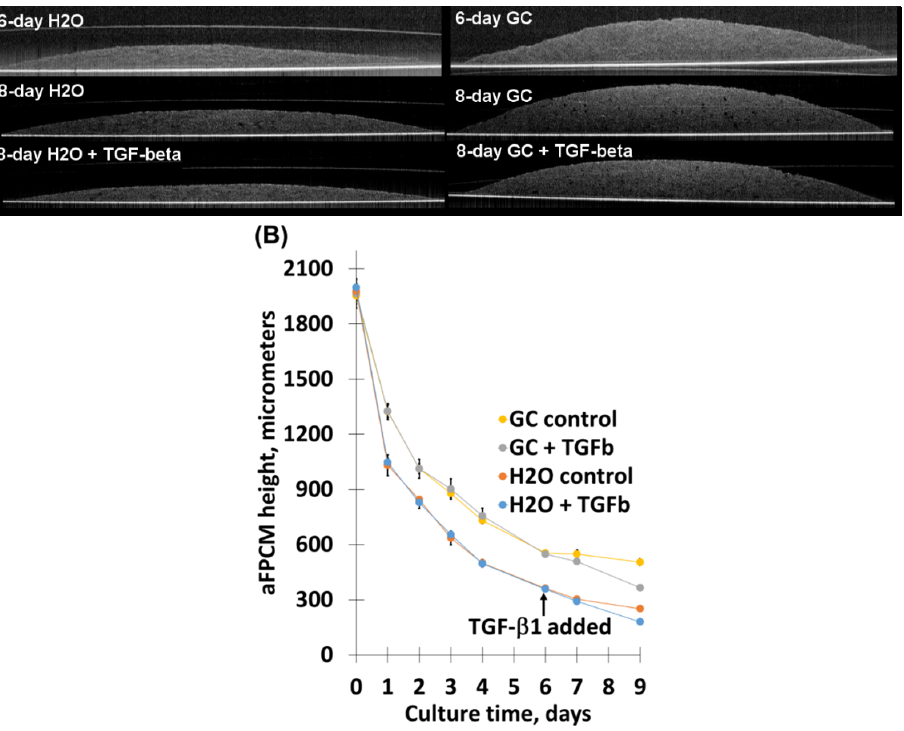
Figure 5. Transforming growth factor beta-1 ( TGF-β1) increased compaction in control and chitosan derivative-incorporated aFPCM. Matrices were allowed to approach maximum compaction on day 6, at which time replicate matrices were divided into control and TGF-β1 (5ng/mL)-treated samples. Compaction was measured for 3 days post-treatment. ( A ) OCT showed the TGF-β1-increased compaction in H 2 O-treated (left images) and GC (right images). ( B ) Graphed compaction averages of both H 2 O and GC aFPCM measured by light microscopy. Note that for each of the measured timepoints, GC compaction < H 2 O. The control means were SD than the TGF-β1-treated control means at days 7 and 9. There was no SD between GC control means and TGF-β1-treated GC means, except at day 9. Other chitosan derivatives demonstrated similar compaction changes with TGF- β 1 across all tested cell